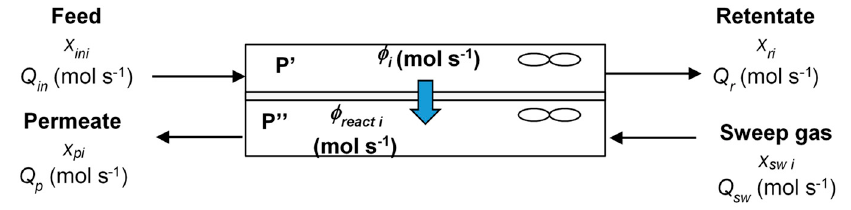
Figure 3. Schematic representation of the experimental module for the molar balance.